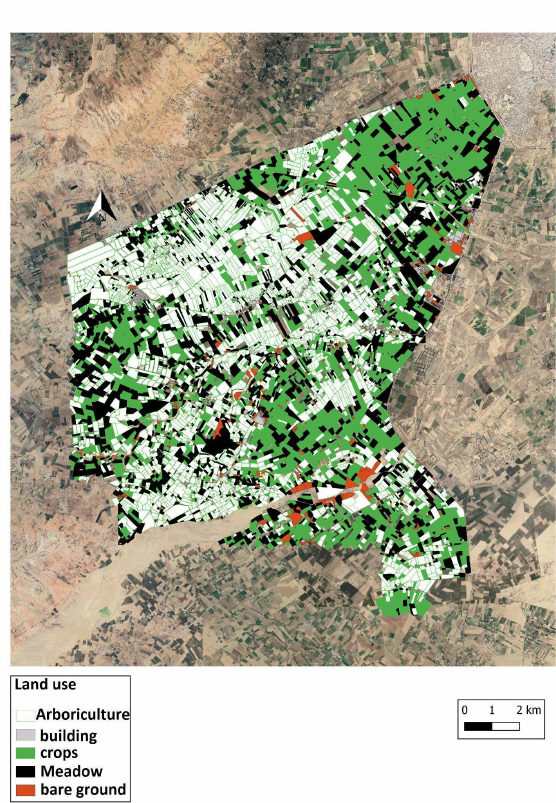
Figure 5. Digitized parcels and photo-interpreted land cover maps using a very high resolution image